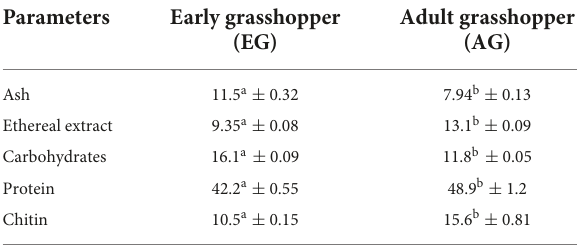
TABLE 1 Proximal composition of grasshopper samples in early and adult stages.